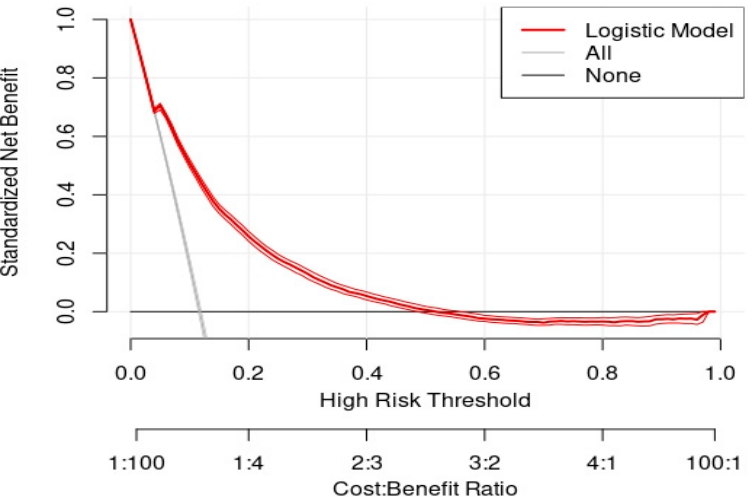
Figure 2. Decision curve analysis across possible probability threshold values for resource utilization using the fitted probabilities from the multivariate logistic regression model with patient-level characteristics and competing resources. Comparative alternative approaches are treat all (outcome resource is expected to be used in all patient visits) and treat none (outcome resource is not expected to be used in any patient visit) alternatives. Net benefit ( y -axis) is displayed by threshold and cost-benefit ratio ( x -axis).